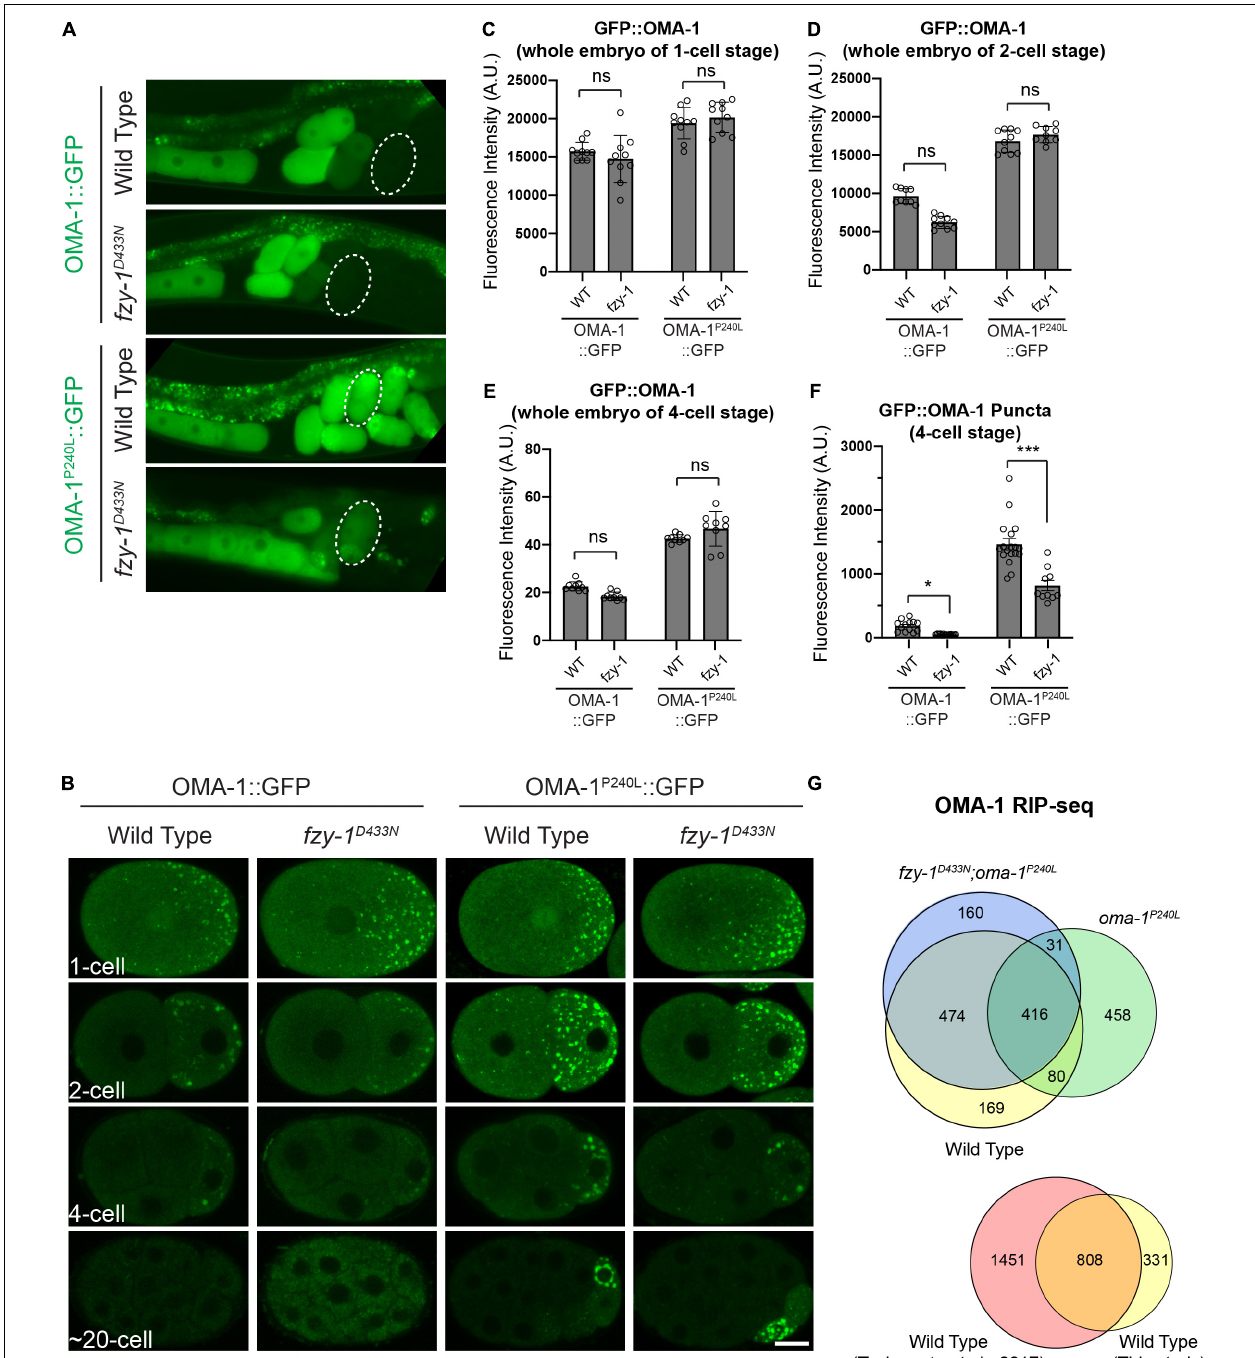
FIGURE 4 | fzy-1 D 433 N mutant affected the OMA-1 distribution in early embryos. (A) Fluorescent micrographs show the localization of OMA-1::GFP and OMA-1 P240L ::GFP in intact gonads in the wild type and fzy-1 D 433 N mutant. 4-cell stage embryos are indicted by dotted white circles. (B) Fluorescent micrographs show the localization of OMA-1::GFP and OMA-1 P240L ::GFP in 1-cell, 2-cell, 4-cell, and ∼ 20-cell stage embryos in the wild type and fzy-1 D 433 N mutant. Scale bar: 10 microns. (C) Quantification of overall OMA-1::GFP fluorescence in 1-cell stage embryos. (D) Quantification of overall OMA-1::GFP fluorescence in 2-cell stage embryos. (E) Quantification of overall OMA-1::GFP fluorescence in 4-cell stage embryos. (F) Quantification of OMA-1::GFP fluorescence enriched in granules in 4-cell stage embryos. The results are presented as the average ± S.D. with individual values plotted. * p < 0.05; *** p < 0.001. The p -values were calculated by 2-way ANOVA followed by Dunnett’s multiple comparisons. N = 8–12. (G) Above: Venn diagram showing the overlap between OMA-1- and OMA-1 P240L -associated RNAs in wild type and fzy-1 D 433 N mutant with a twofold enrichment cutoff. Bottom: Venn diagram showing the overlap between OMA-1-associated RNAs